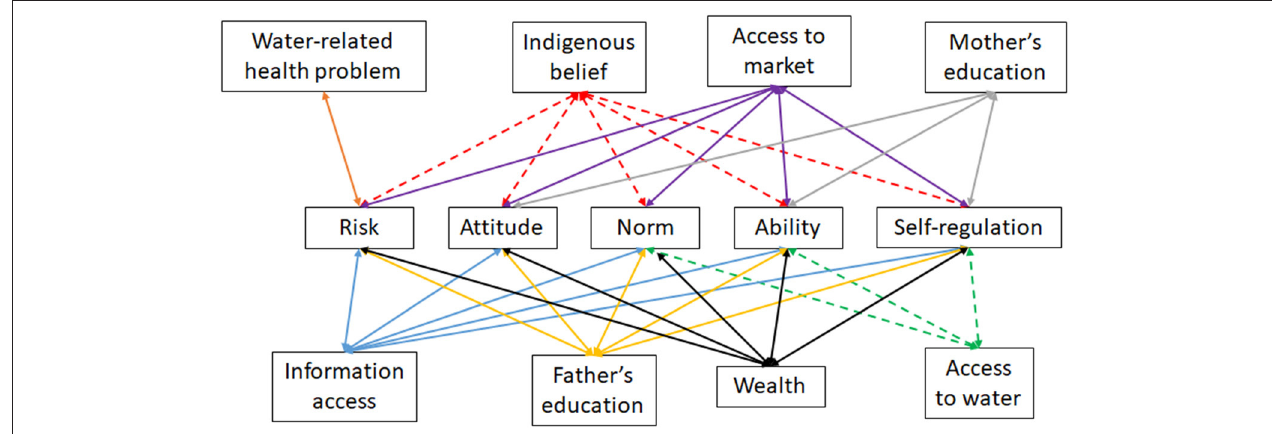
FIGURE 4 | Correlation relationship between SEC and RANAS psychological factors. Solid lines indicate positive correlation and dashed lines indicate negative correlation (Pearson correlation, p ≤ 0.05).